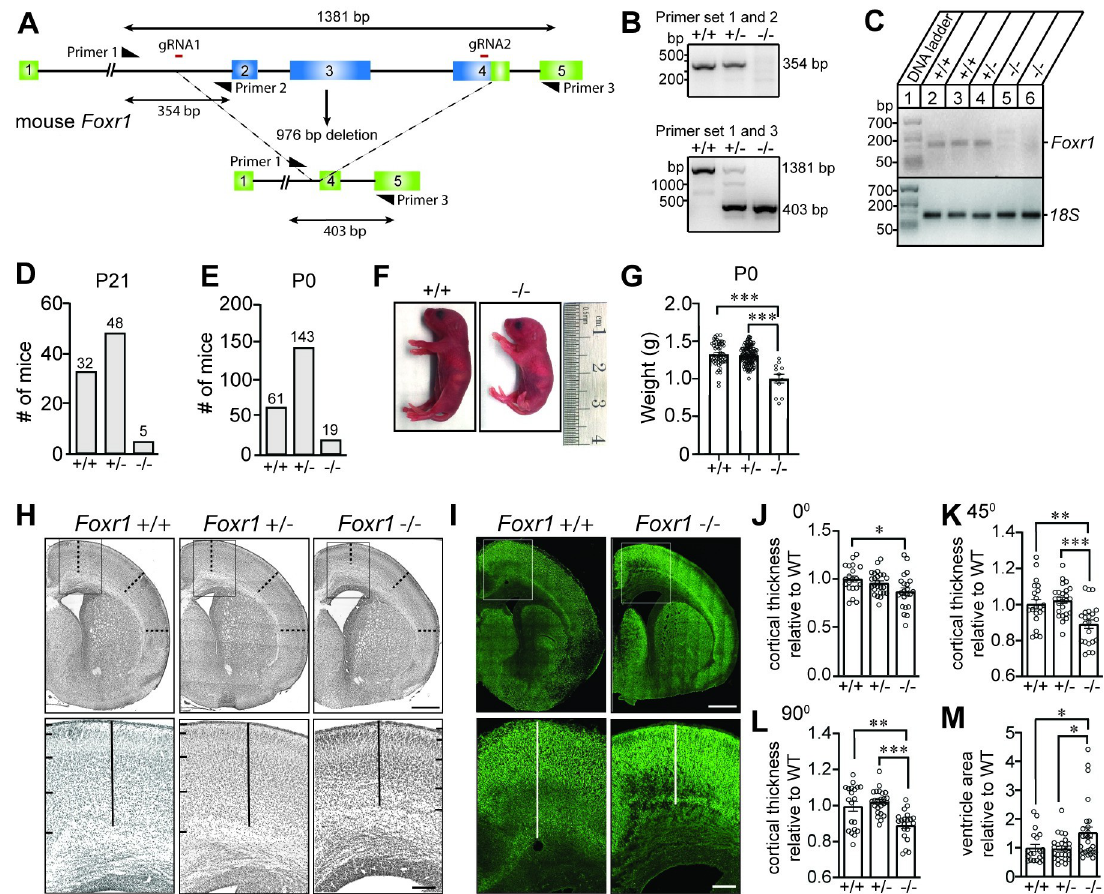
Fig 8. Foxr1 knockout mice exhibit cortical thinning and enlarged ventricles. (A) Representative schematic view of the CRISPR/Cas9 targeting strategy used for generating Foxr1 knockout mice. The Foxr1 locus consists of 5 exons (colored boxes), and introns (black lines). Two gRNAs (red lines), one upstream located in intron 1 and one downstream located within exon 4 were used to target the Foxr1 gene and remove 976 nucleotides encompassing exons 2, 3 and part of exon 4 (blue box). Primers are represented by black half arrowheads to indicate the relative locations of forward (primer 1) and reverse genotyping primers (primers 2 and 3). (B) Representative PCR genotyping result for primer set 1 and 2 (indicated in panel A) to detect Foxr1 wild-type allele (354 bp). Below is a representative PCR genotyping result for primer set 1 and 3 to detect Foxr1 wild-type (1381 bp), heterozygous (1381 for wild-type and 403 bp for knockout), and knockout alleles (403 bp). (C) RT-PCR of Foxr1 (175 bp) and 18S ribosomal transcripts (129 bp) from brains of wild-type and Foxr1 knockout mice. (D) Genotype analysis of number of offspring obtained from Foxr1 heterozygous crossings at postnatal day 21 (P21). (E) Genotype analysis of number of newborn offspring obtained from Foxr1 heterozygous crossings at postnatal day 0 (P0). (F) Lateral view of wild-type and Foxr1 knockout neonates showing a decrease in size in the Foxr1 knockout mutant. (G) Body weight measurements (in grams) for Foxr1 wild-type (n = 53), heterozygous (n = 120) and knockout mice (n = 12) at postnatal day 0 showing a decrease in Foxr1 knockout mice. One-way ANOVA Tukey’s multiple comparisons ( ��� p < 0.001). (H) Nissl stain brain sections of Foxr1 wild-type (+/+), heterozygous (+/-) and knockout (-/-) mice. Top panel shows coronal sections anterior to bregma. Dashed lines represent cortical measurements at 0˚, 45˚ and 90˚ (relative to the midline) to pia surface. White box indicates higher magnification for the bottom panels. Scale bar = 500 μ m. Bottom panels represents higher magnification of the cortex where the vertical line indicates cortical thickness measurements. Side bars demarcates the different cortical layers. Scale bar = 125 μ m. (I) MAP2 immunostaining of brain sections of Foxr1 wild-type and knockout mice. Top panel shows coronal sections anterior to bregma. White box indicates higher magnification for the bottom panels. Scale bar = 500 μ m. Bottom panels represents higher magnification of the cortex where the vertical line indicates cortical thickness measurements. Scale bar = 125 μ m. (J-L) Quantification of cortical thickness from pooled brain sections of 4 wild-type, 4 heterozygous and 4 Foxr1 knockout mice at 0˚, 45˚ and 90˚ (relative to the midline) to pia surface, respectively. Graph represents relative thickness normalized to wild-type (WT). One-way ANOVA Tukey’s multiple comparisons (0˚, � p = 0.0165; 45˚, �� p = 0.0033, ��� p = 0.0003; 90˚, �� p = 0.0019, ��� p < 0.0001) (M) Quantification of ventricle area from pooled brain sections of 4 wild-type and 4 Foxr1 knockout mice. Graph represents relative thickness normalized to wild-type (WT). One-way ANOVA Tukey’s multiple comparisons � p = 0.04 wild-type and knockout; p = 0.02 heterozygous and knockout.